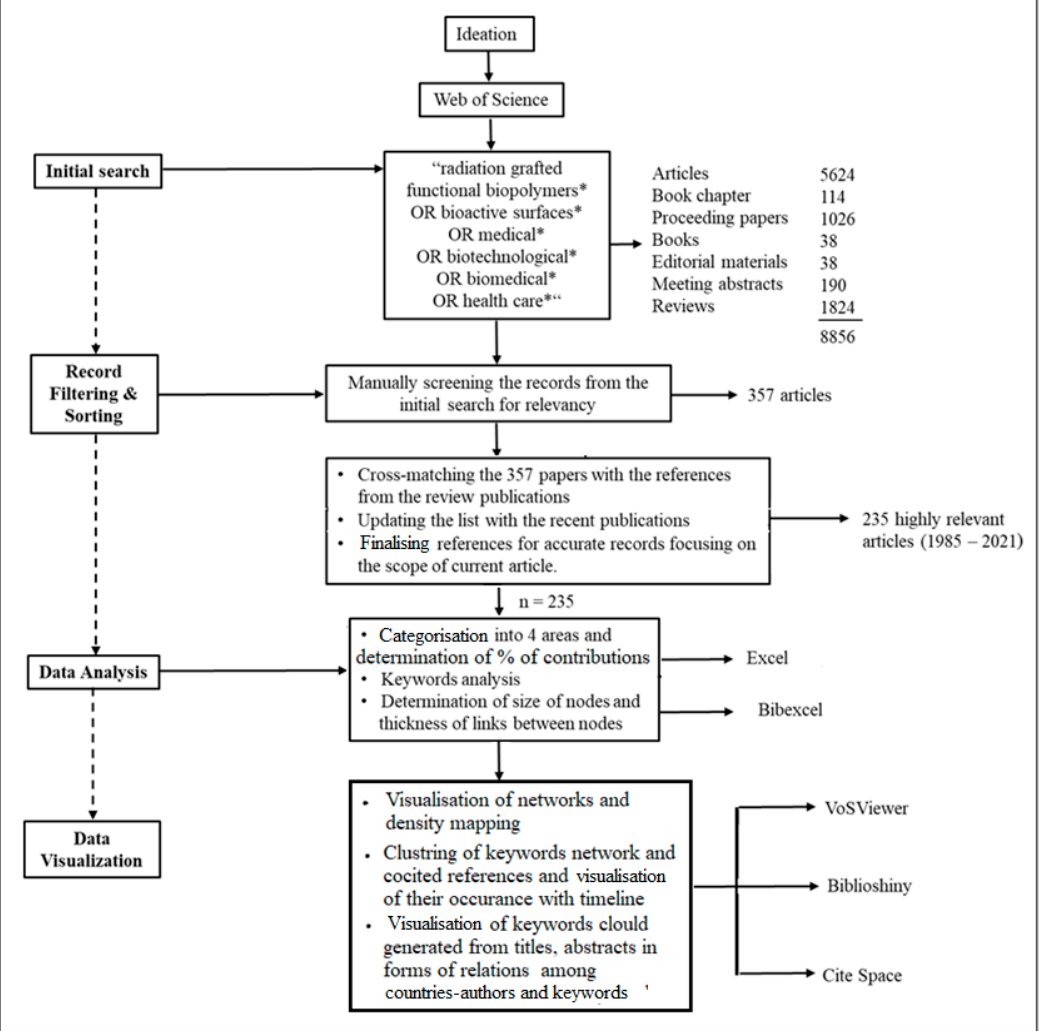
Figure 3. Multi-step strategy used to evaluate the bibliometrics of FPBMs prepared by RIGC.